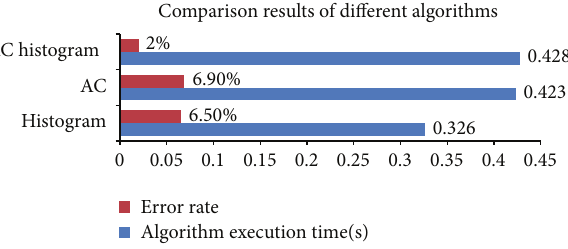
Figure 18: Comparison of different